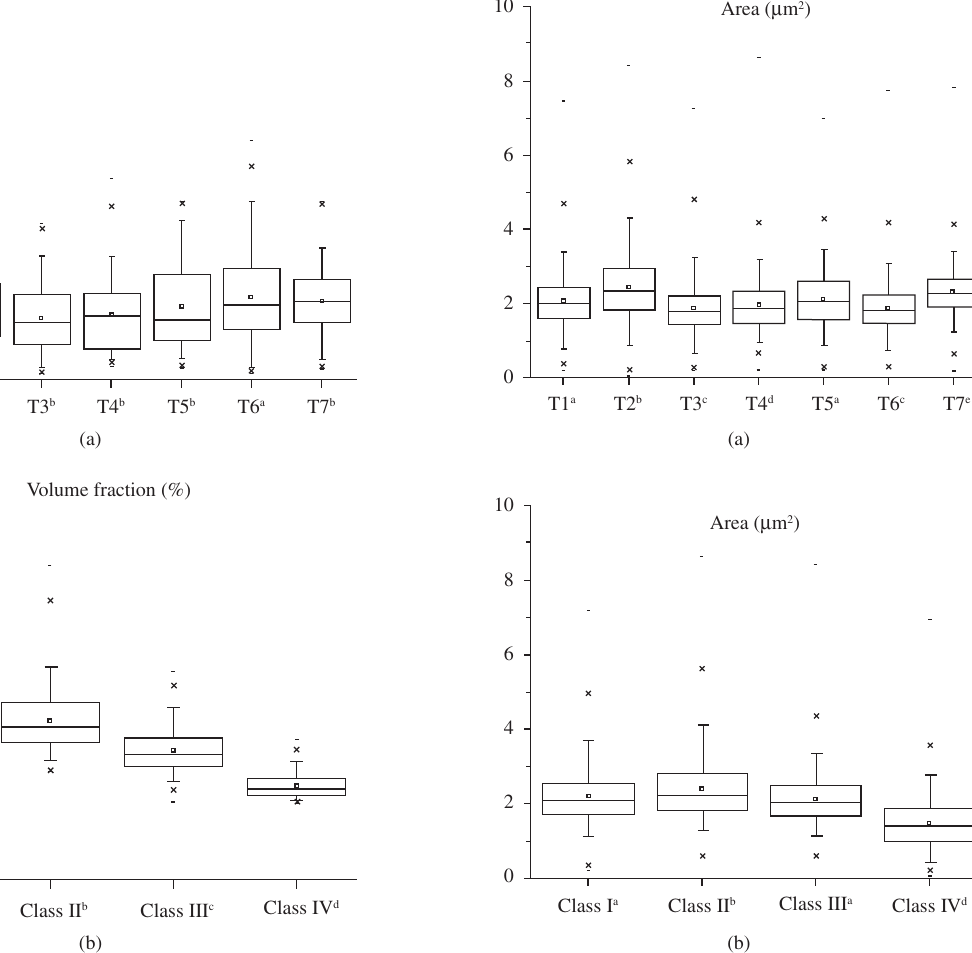
Figure 5. Variation of the volume fraction of tubules a) per tooth and b) per class of dentin.